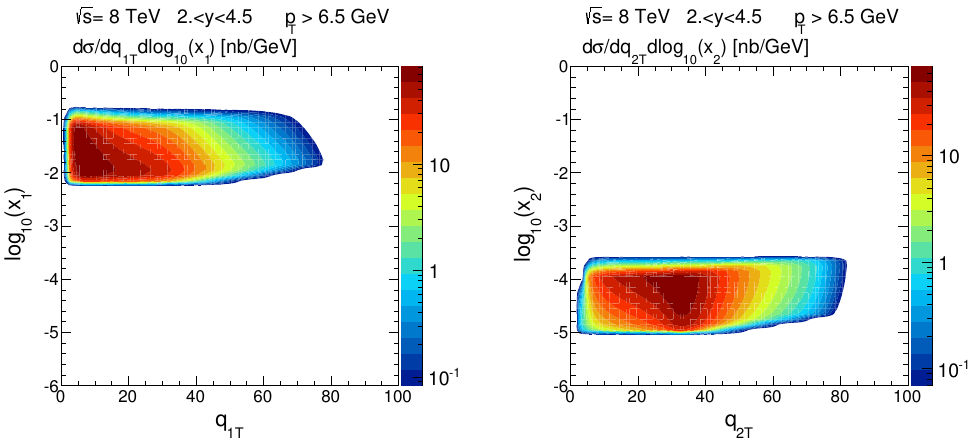
Figure 2 . Two-dimensional distributions in ( x 1 ; q 1 T ) (left panel) and in ( x 2 ; q 2 T ) (right panel) for p (cid:17) c (1 S ) production for s = 8 TeV. In this calculation the KMR UGD was used for